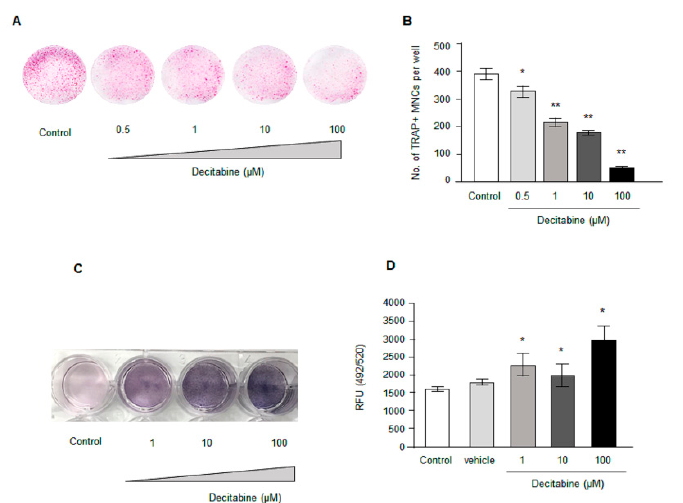
Figure 2. Effects of decitabine on osteoclast differentiation in vitro. ( A ) Representative images showing osteoclastogenesis in CD14 + monocytes in the presence of various concentrations of decitabine (0.1, 1, 10 or 100 µ M). ( B ) Averaged data for the number of tartrate-resistant acid phosphatase-positive multinuclear osteoclasts (TRAP+ MNCs) per well. ( C ) MC3T3-E1 cells cultured in osteogenic differentiation media in the presence of Decitabine for three days. ALP staining was performed after osteogenic stimulation. ( D ) MC3T3-E1 cells cultured in osteogenic differentiation media in the presence of Decitabine for two weeks. Decitabine dose dependently increased osteo-mineralization. * p < 0.05, ** p < 0.01 vs. control. Note that vehicle indicates the osteogenic differentiation media with 0.1% DMSO.